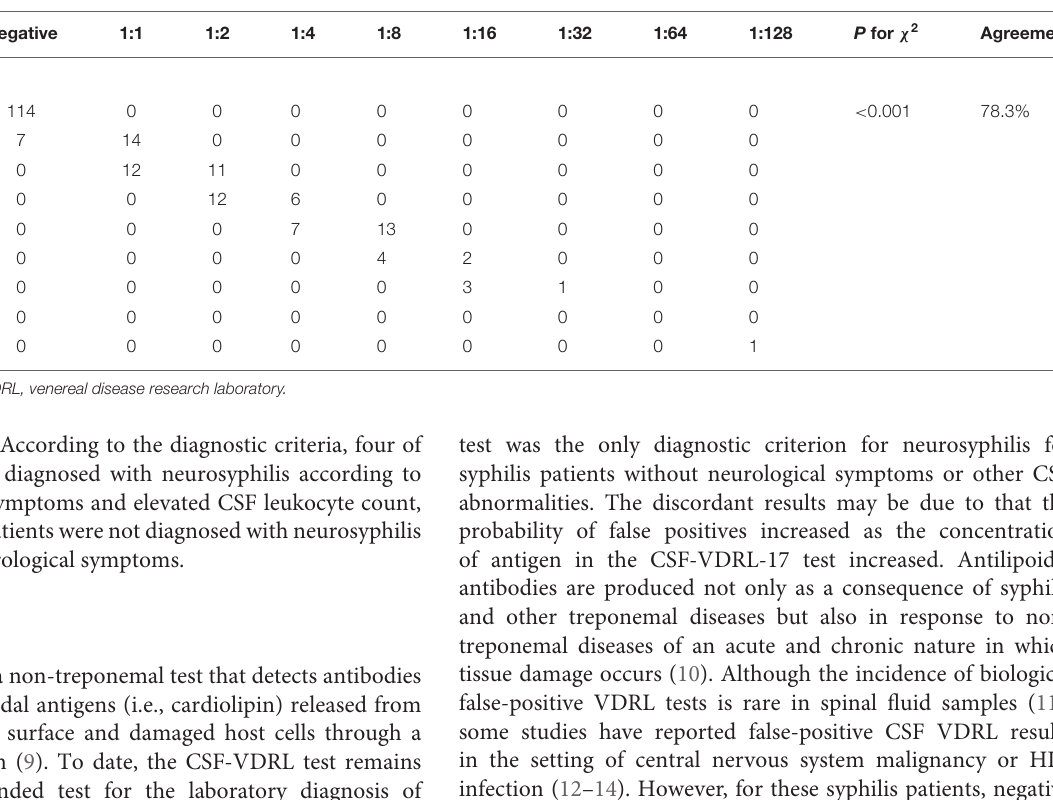
TABLE 3 | The agreement between the qualitative and quantitative CSF-VDRL-10 and CSF-VDRL-17 tests.